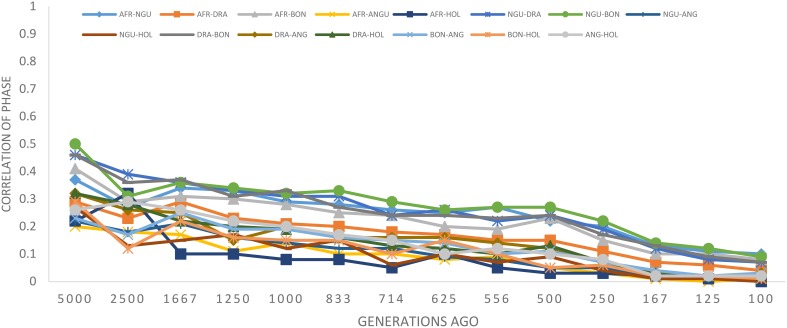
Correlation of allele phase by physical distance represented as generations in the past.